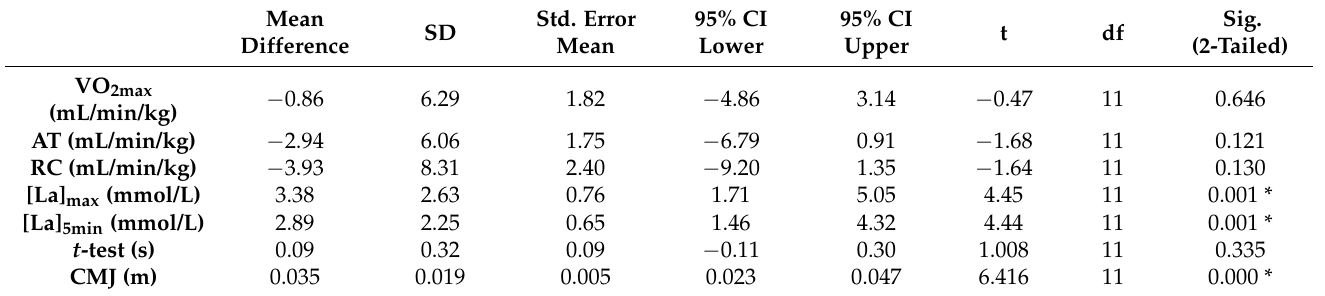
Table 3. Paired samples test of other performance related parameters before and after 50% EA reduction.